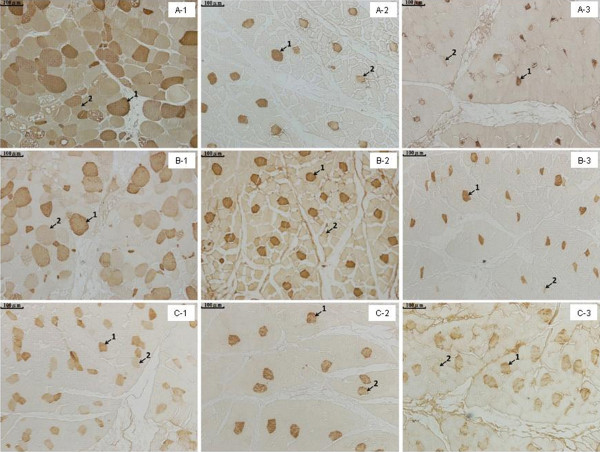
Immunohistochemical localization of CA-III in the muscles from normal and muscular dystrophic chickens.A-1, the superficial pectoral muscle of a dystrophic chicken A; A-2, the tensor fasciae latae muscle of a dystrophic chicken A; A-3, the obliquus externus abdominis muscle of a dystrophic chicken A; B-1, the superficial pectoral muscle of a dystrophic chicken B; B-2, the tensor fasciae latae muscle of a dystrophic chicken B; B-3, the obliquus externus abdominis muscle of a dystrophic chicken B; C-1, the superficial pectoral muscle of a normal chicken; C-2, the tensor fasciae latae muscle of a normal chicken; and C-3, the obliquus externus abdominis muscle of a normal chicken. Arrow 1 indicates strongly stained CA-III. Arrow 2 indicates weakly stained CA-III. Scale bars: 100 μm.